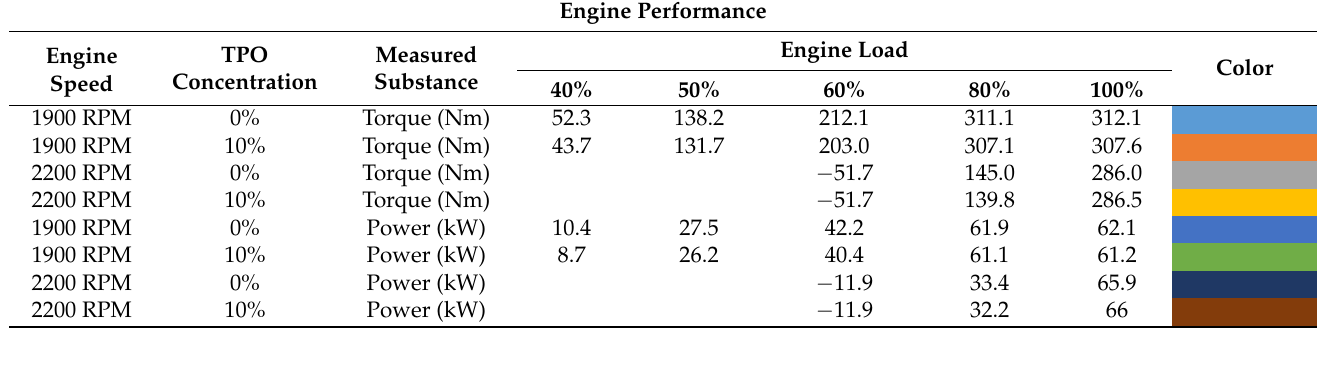
Figure 5. Design of a resonant cell [12].